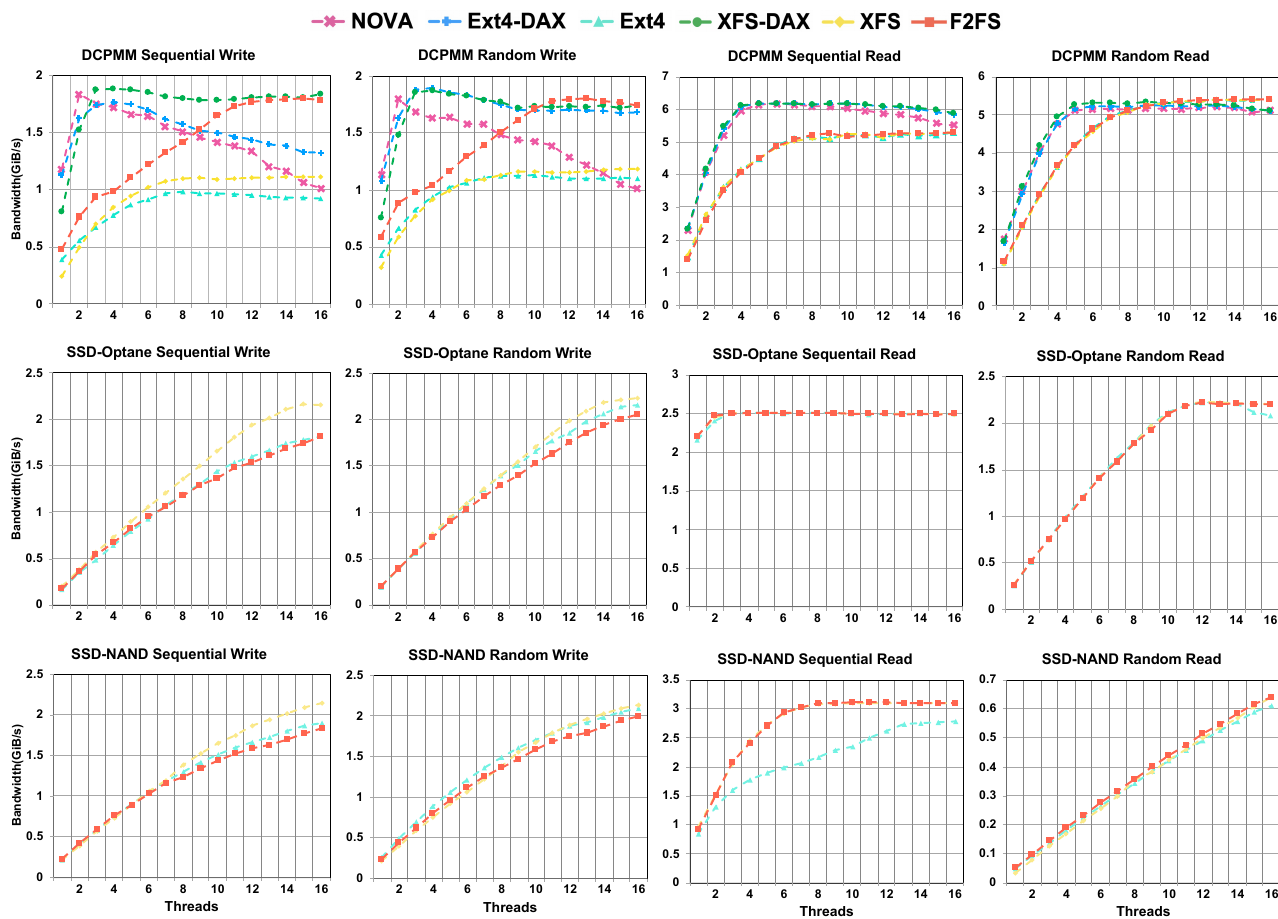
Figure 1. The read/write performance of traditional and NVM-aware file systems on Optane DCPMM, Optane SSD, and NAND-flash